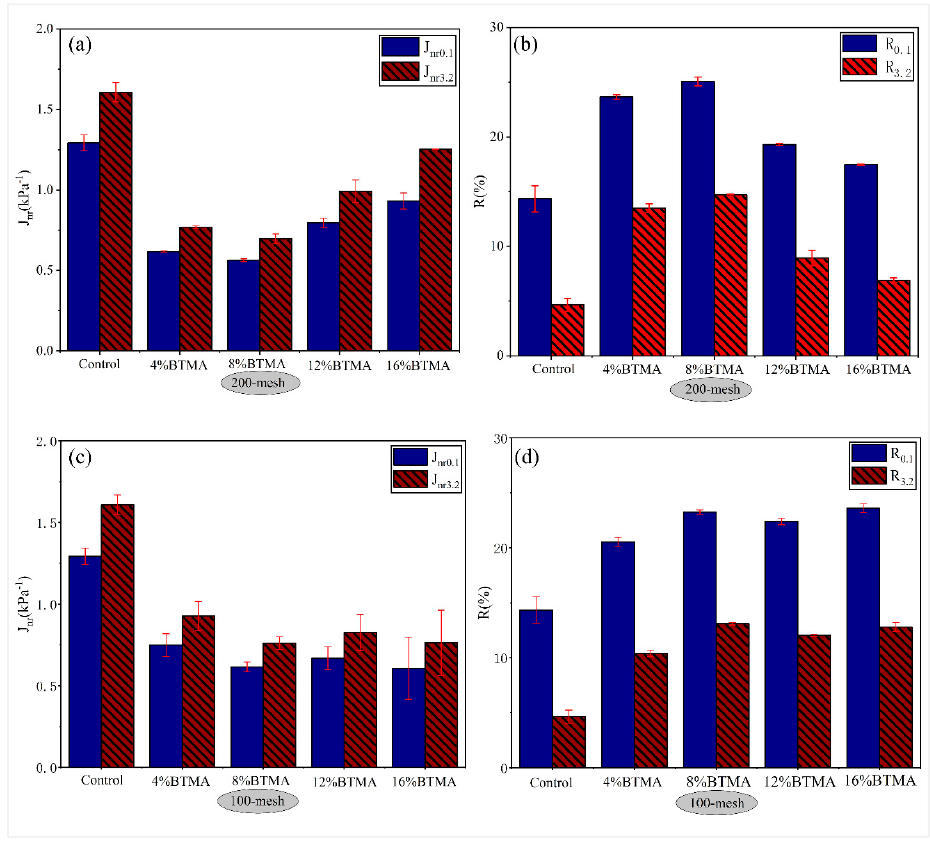
Figure 7. J nr and R for BTMAs with various toner particle sizes: ( a ) J nr 200-mesh, ( b ) R200-mesh, ( c ) J nr 100-mesh, and ( d ) R100-mesh.